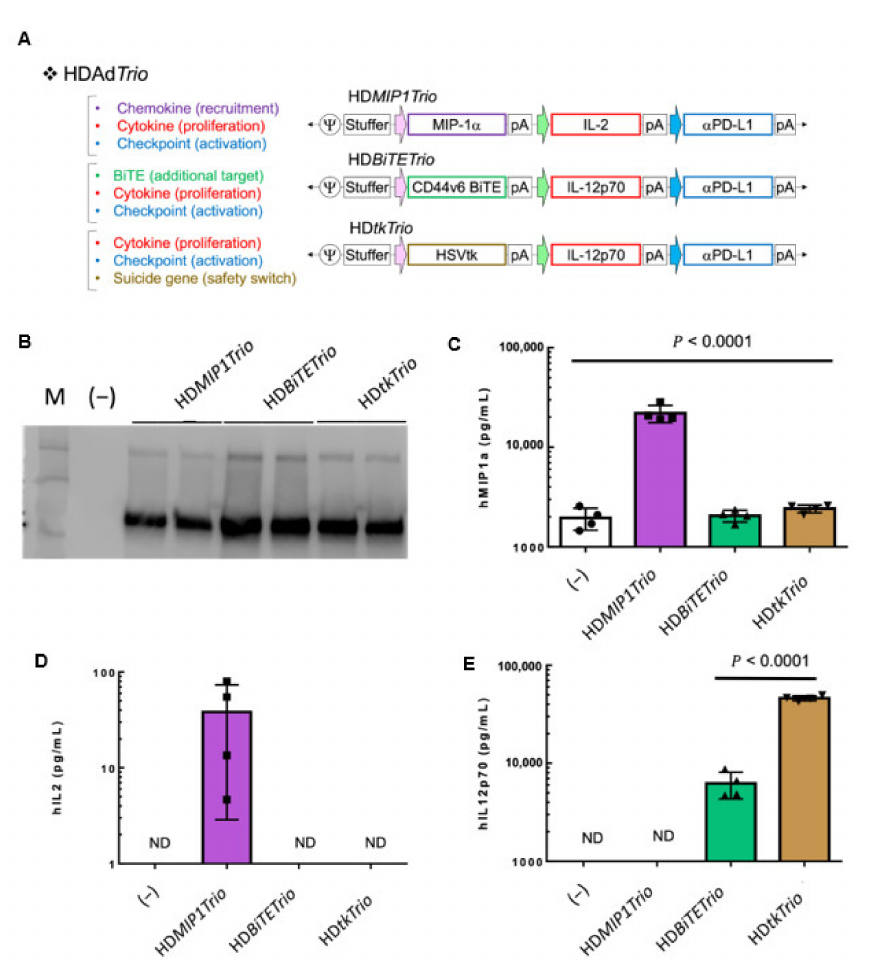
Figure 4. Simultaneous expression of different transgenes from HDTrio. ( A ) Schematic structure of HD5/3 Trios . HD5/3 MIP1Trio encodes human MIP1 α , IL2, and anti-PDL1 minibody expression cassettes. HD5/3 BiTETrio encodes the CD44v6.BiTE, human IL12p70, and anti-PDL1